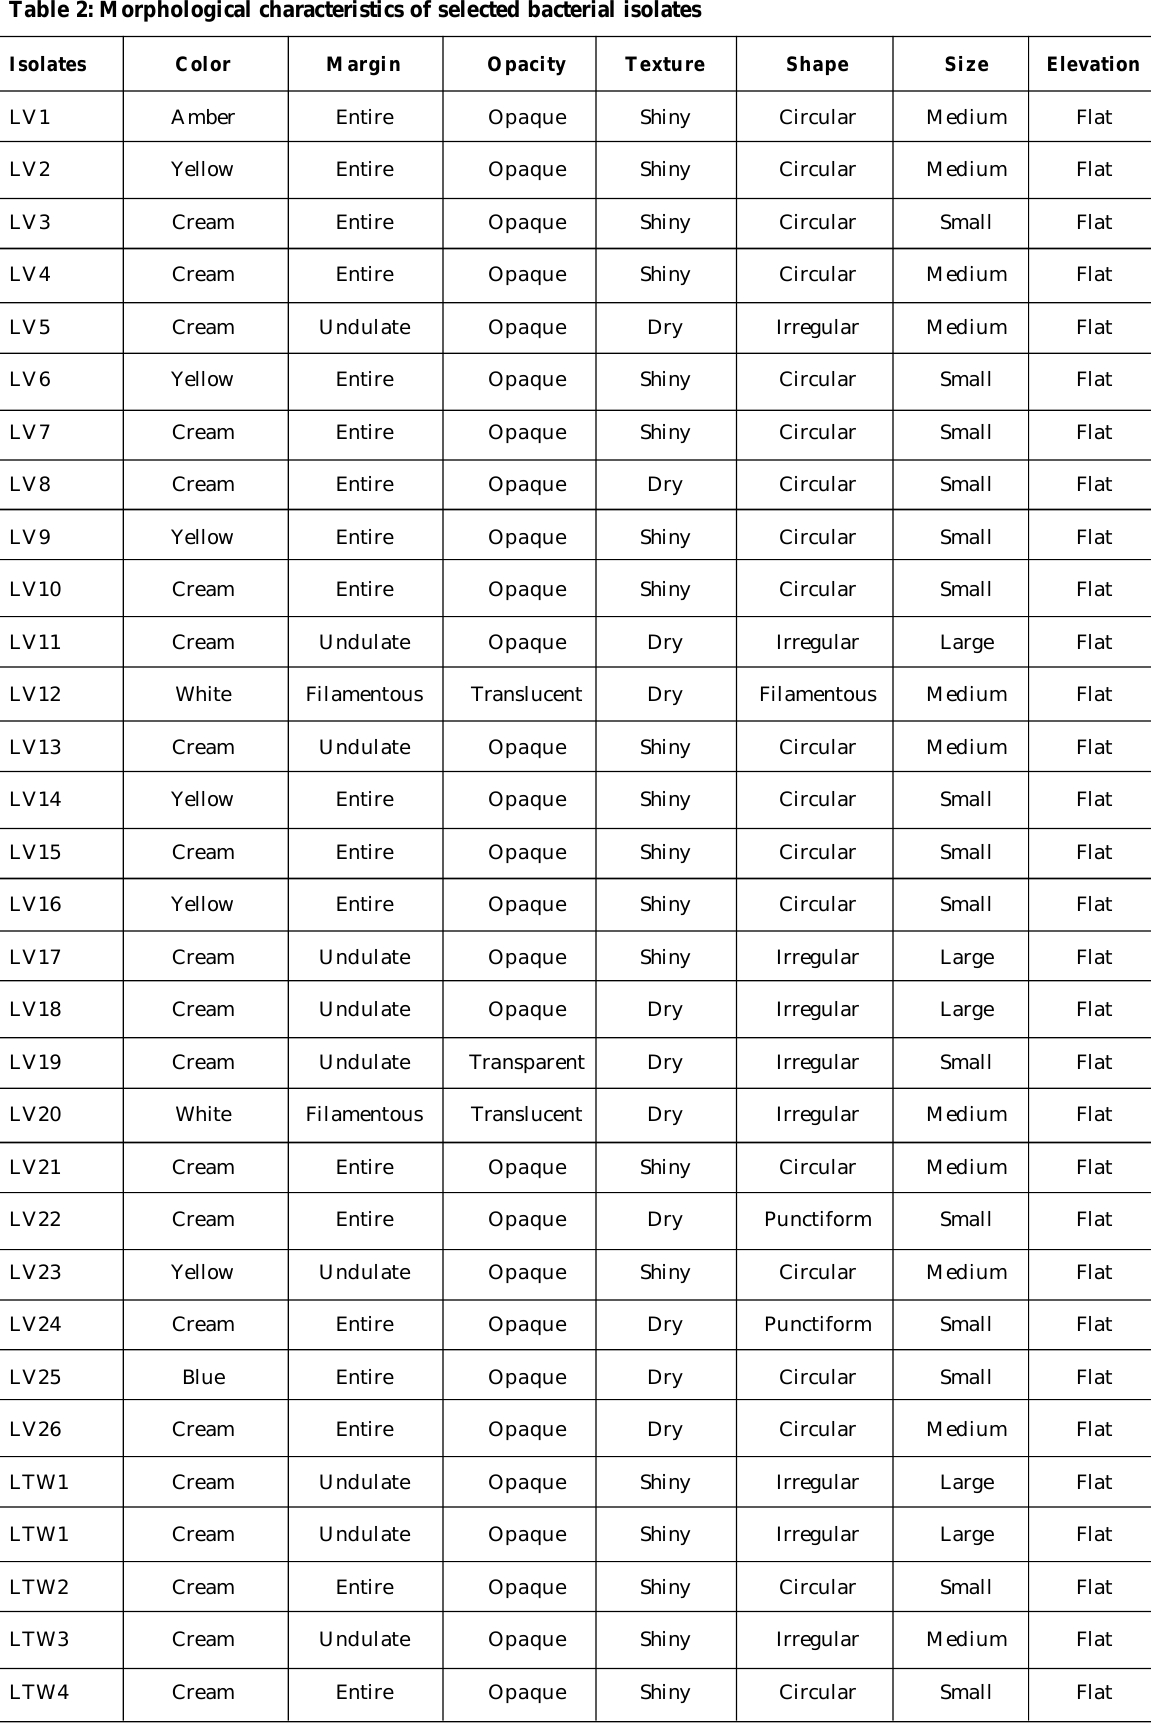
Table 2: Morphological characteristics of selected bacterial isolates